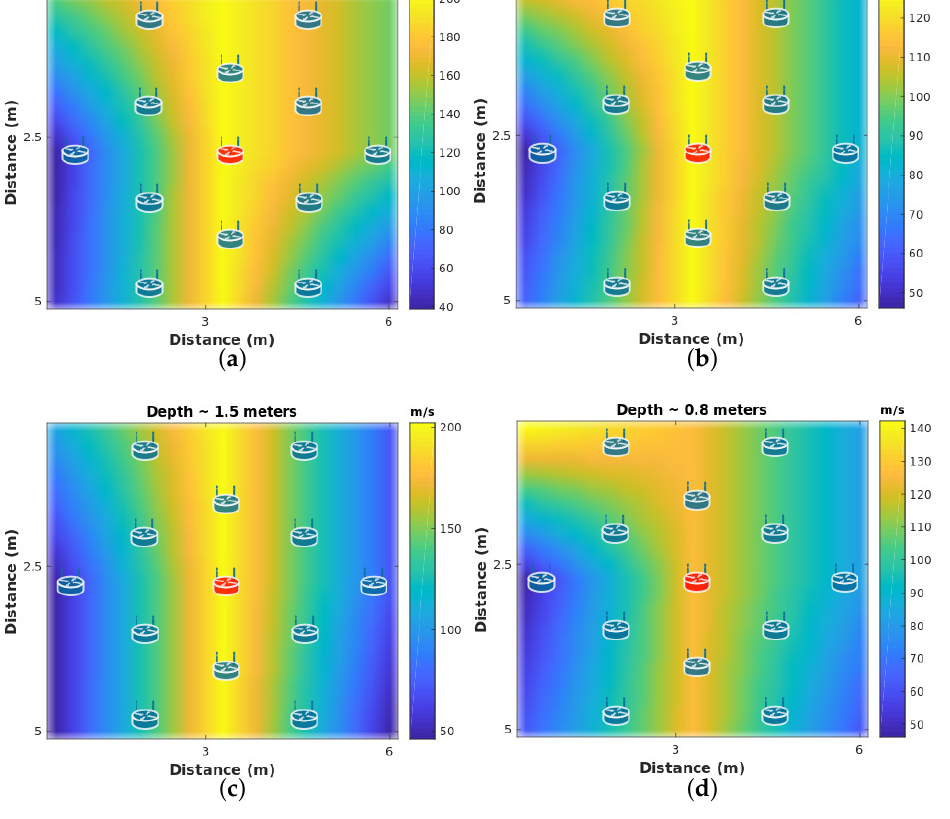
Figure 13. Velocity Maps. ( a ) Layer ∼ 5.1 m depth. ( b ) Layer ∼ 3.5 m depth. ( c ) Layer ∼ 1.5 m depth. ( d ) Layer ∼ 0.8 m depth. Sensor-node locations are plotted as